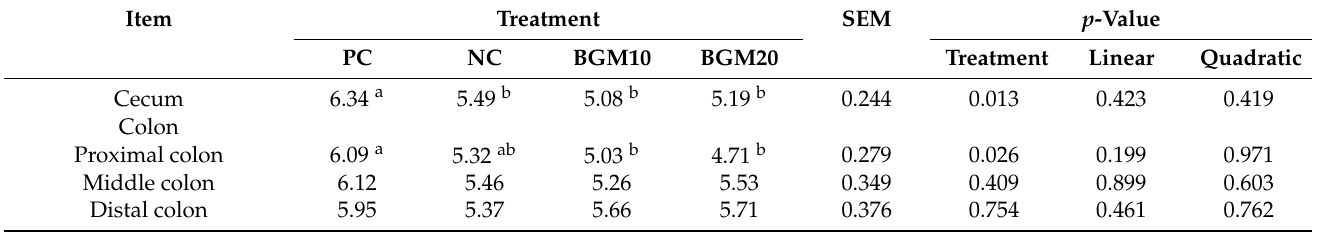
Table 5. Effect of dietary BGM with multienzyme addition on hindgut pH in weaning pigs 1,2